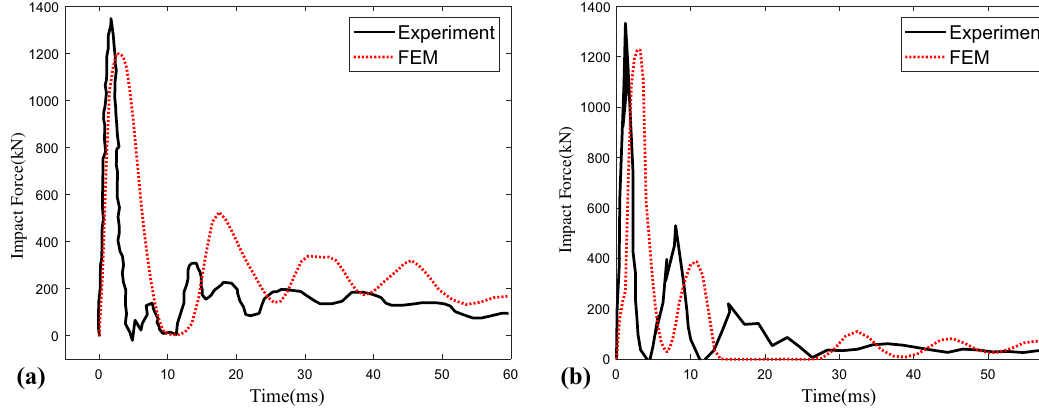
Fig. 6 Impact force: a B-1700-4.6, b C-1700-4.6